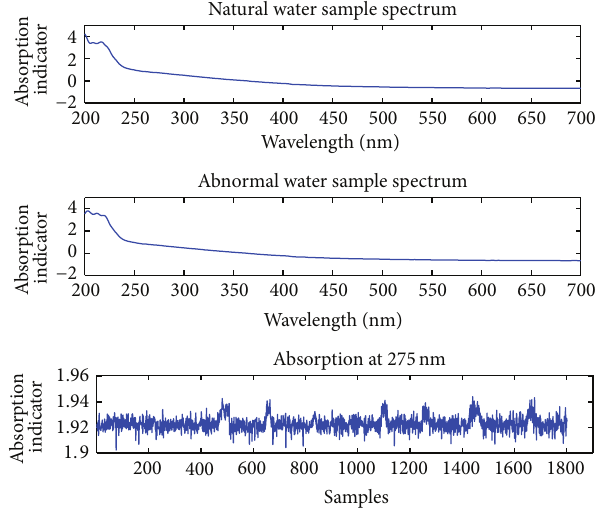
Figure 4: Online monitoring